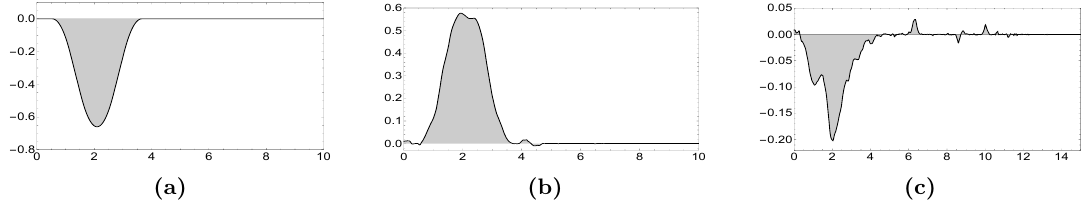
Figure 29. The shell-type oscillon at R + for l = 3 : 0 at (a) t = 0 : 931, (b) t = 13 : 799, (c) t = 25 : 765. to the initial oscillon and interact with it. The second feature is related to the existence of ball shaped oscillons | inherited from the signum-Gordon model on R